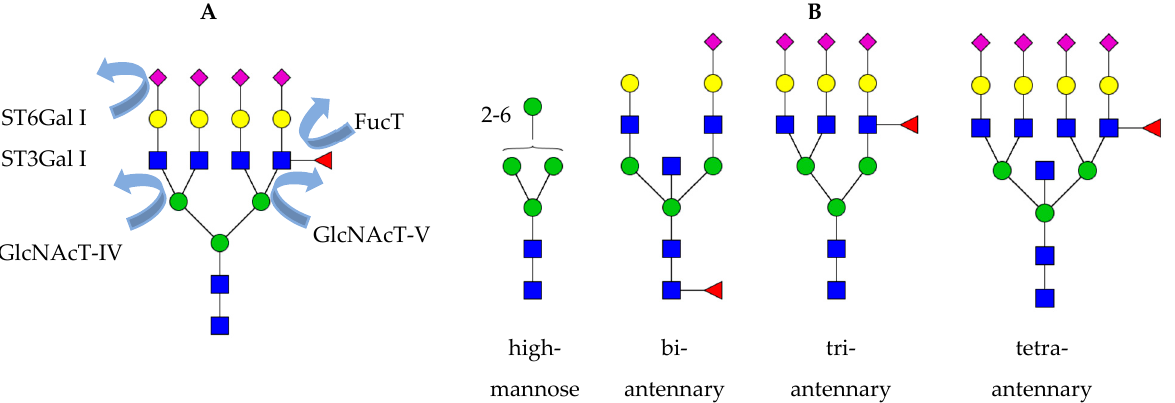
Figure 1. ( A ) Overview of the glycosyltransferases that are upregulated in cancer. GnT-IV, N -acetylglucosaminyltransferase IV; GnT-V, N -acetylglucosaminyltransferase IV; ST3Gal I, β -galactoside alpha-2,3-sialyltransferase 1; ST6Gal I, β -galactoside alpha-2,6-sialyltransferase 1; FucT, α 1-3-fucosyltransferase. ( B ) N -Glycan structures that are of relevance in glycan biomarker studies on OvCa. At the level of total serum, high-mannose and biantennary bisecting N -glycans are downregulated, whereas sialylated fucosylated tri- and tetraantennary N -glycans are upregulated when primary OvCa patients as compared with controls. Besides, elevated bisecting N -glycans and some sialylated fucosylated tetraantennary structures have also been proposed as a marker for resistance to chemotherapy. Green circle, mannose; yellow circle, galactose; blue square, N -acetylglucosamine; red triangle, fucose; purple diamond, N -acetylneuraminic acid .